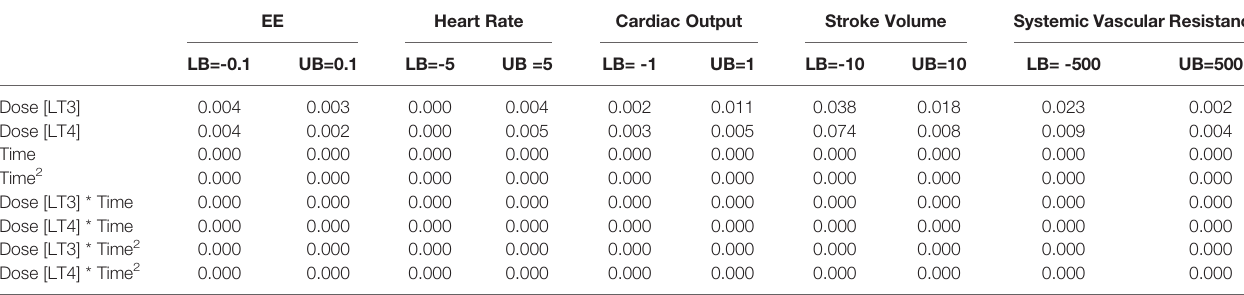
TABLE 6 | Equivalence tests (TOST procedure) of the estimated effect sizes in Table 4 . EE